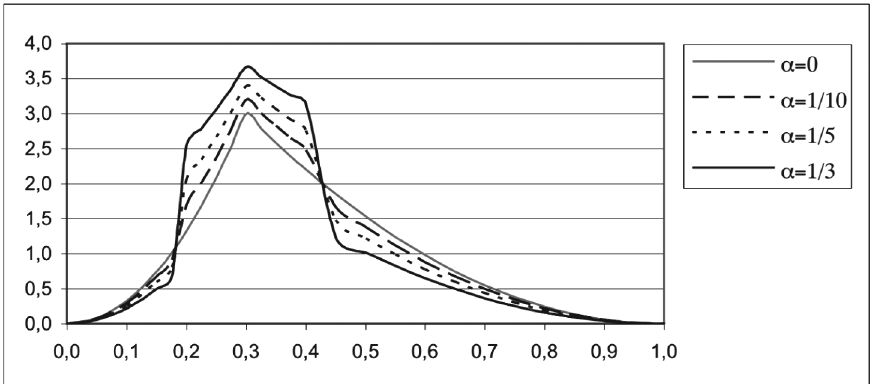
Figure 3 – Probability density function of some MTSP distributions ( κ =3, θ = 0.3, α variable, β =0.2